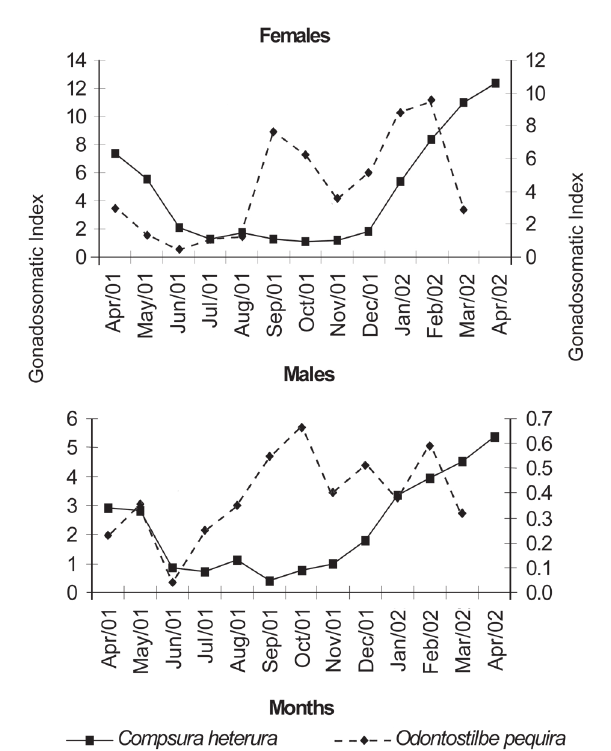
Fig. 4. Monthly variation of the mean of the gonadossomatic index (GSI) for females and males of Compsura heterura and of Odontostilbe pequira collected in the rio Ceará-Mirim, RN, and in the rio Ibicuí-Mirim, RS, from April 2001 to April 2002.